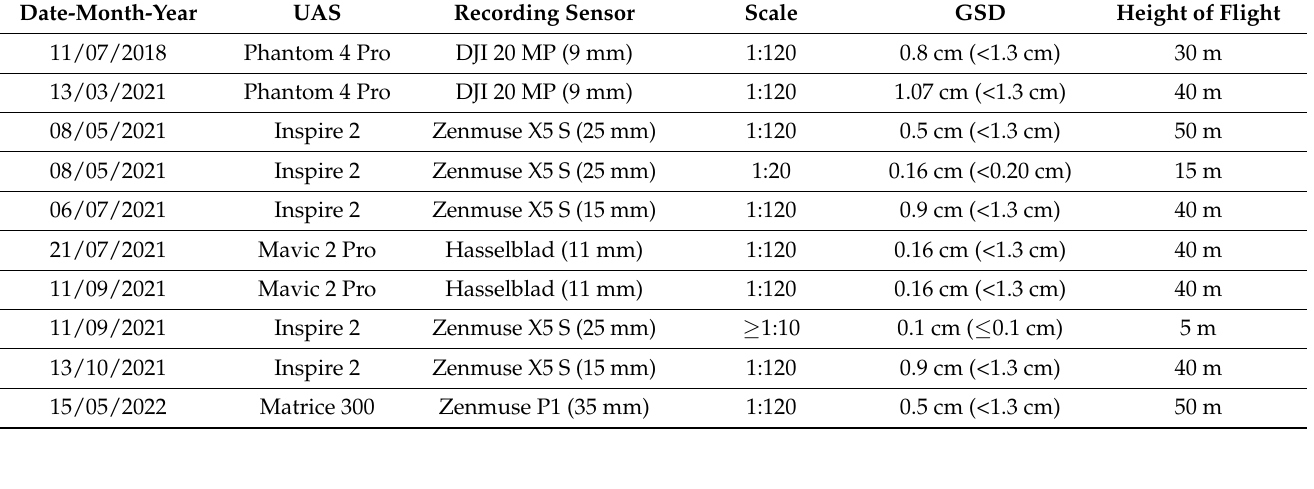
Table 2. Recording dates, UAS type, cartographic scale, corresponding GSD, and flight altitude.